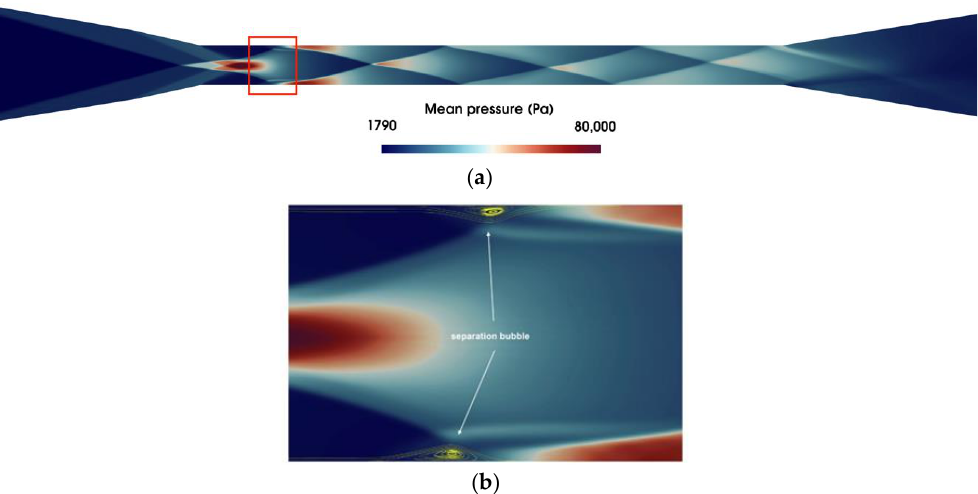
Figure 9. Pressure contours of ( a ) 3D-nonequilibrium case; ( b ) 3D-nonequilibrium case, zoomed in for the first shock reflection points for the x - y plane along z = 0.